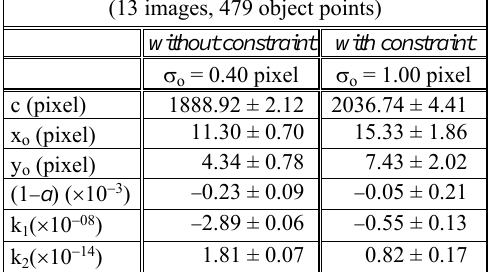
Table 4. Calibration results for image set 4 (13 images, 479 object